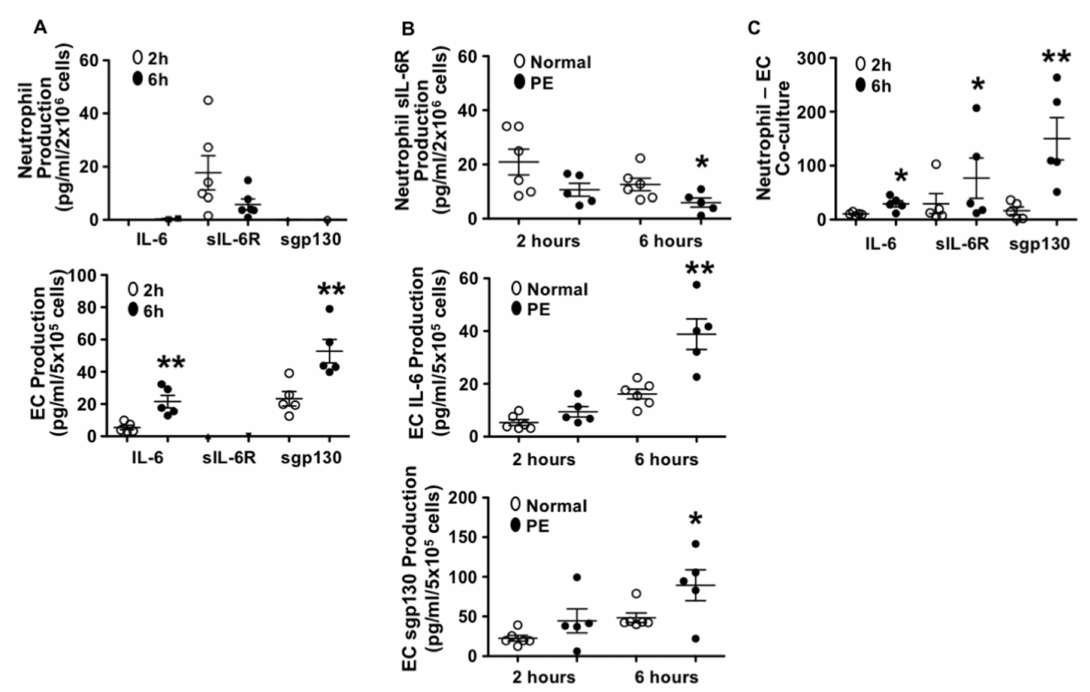
Figure 1. Production of interleukin 6 (IL-6), soluble IL-6R (sIL-6R), and soluble gp130 (sgp130) by neutrophils and endothelial cells from normal and preeclamptic (PE) pregnancies. ( A ) Production of IL-6, sIL-6R, and sgp130 by neutrophils (n = 6) and endothelial cells (n = 5) from normal pregnant women. Open symbol: 2 h of culture, and solid symbol: 6 h of culture, ** p < 0.01: 6 h vs. 2 h. ( B ) Comparison of sIL-6R production by neutrophils (normal n = 6; PE n = 5), and IL-6 and sgp130 production by endothelial cells (normal n = 6; PE n = 5) from normal vs. PE pregnancies. Open symbol: normal and solid symbol: PE, * p < 0.05 and ** p < 0.01: PE vs. normal at 6 h. ( C ) Production of IL-6, sIL-6R, and sgp130 in co-cultured neutrophils and endothelial cells. Freshly isolated neutrophils (2 × 10 6 cells) were added into cultured endothelial cells (5 × 10 5 cells/per well in 6 well plate). Both neutrophils and endothelial cells were from normal pregnancy. Results were from five independent experiments. Open symbol: 2 h of culture and solid symbol: 6 h of culture, * p < 0.05 and ** p < 0.01: 6 h vs. 2 h,